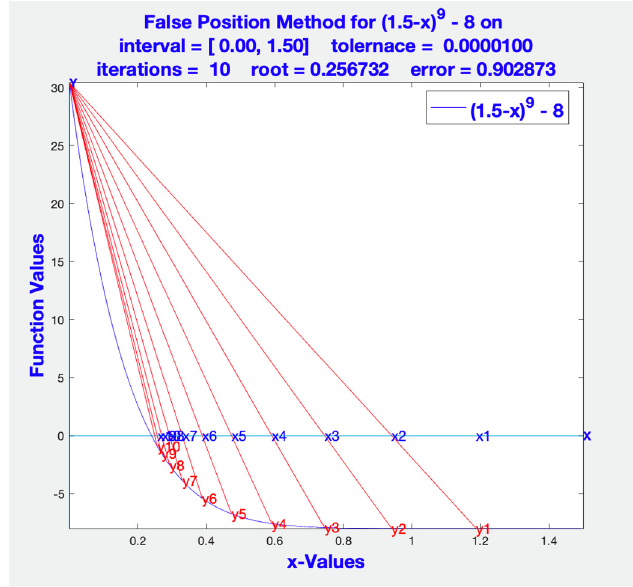
Figure 3. Convex function concave down, right endpoint fixed.